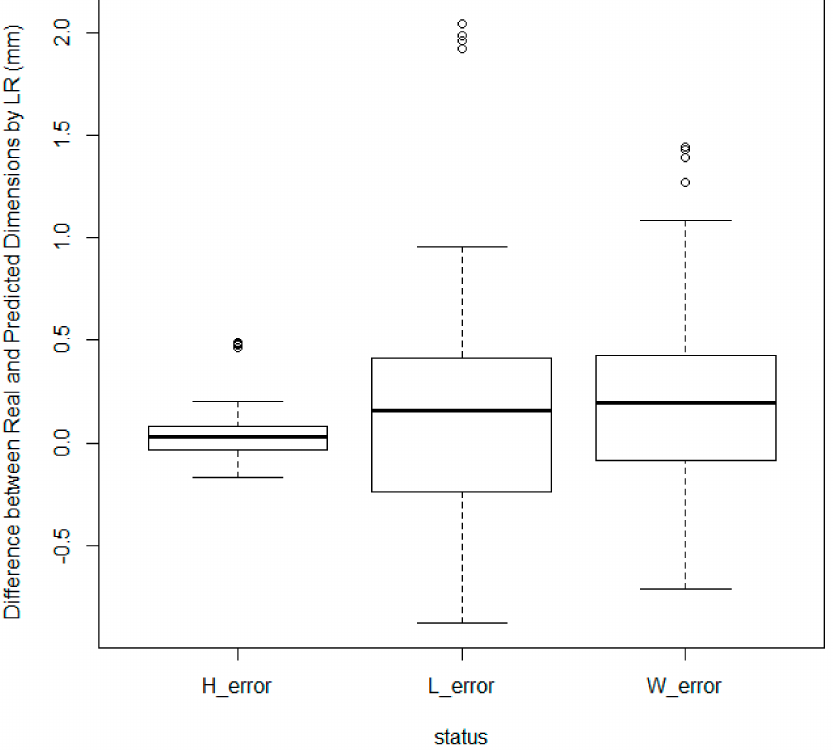
Figure 6. Difference between real and predicted CAD dimensions by